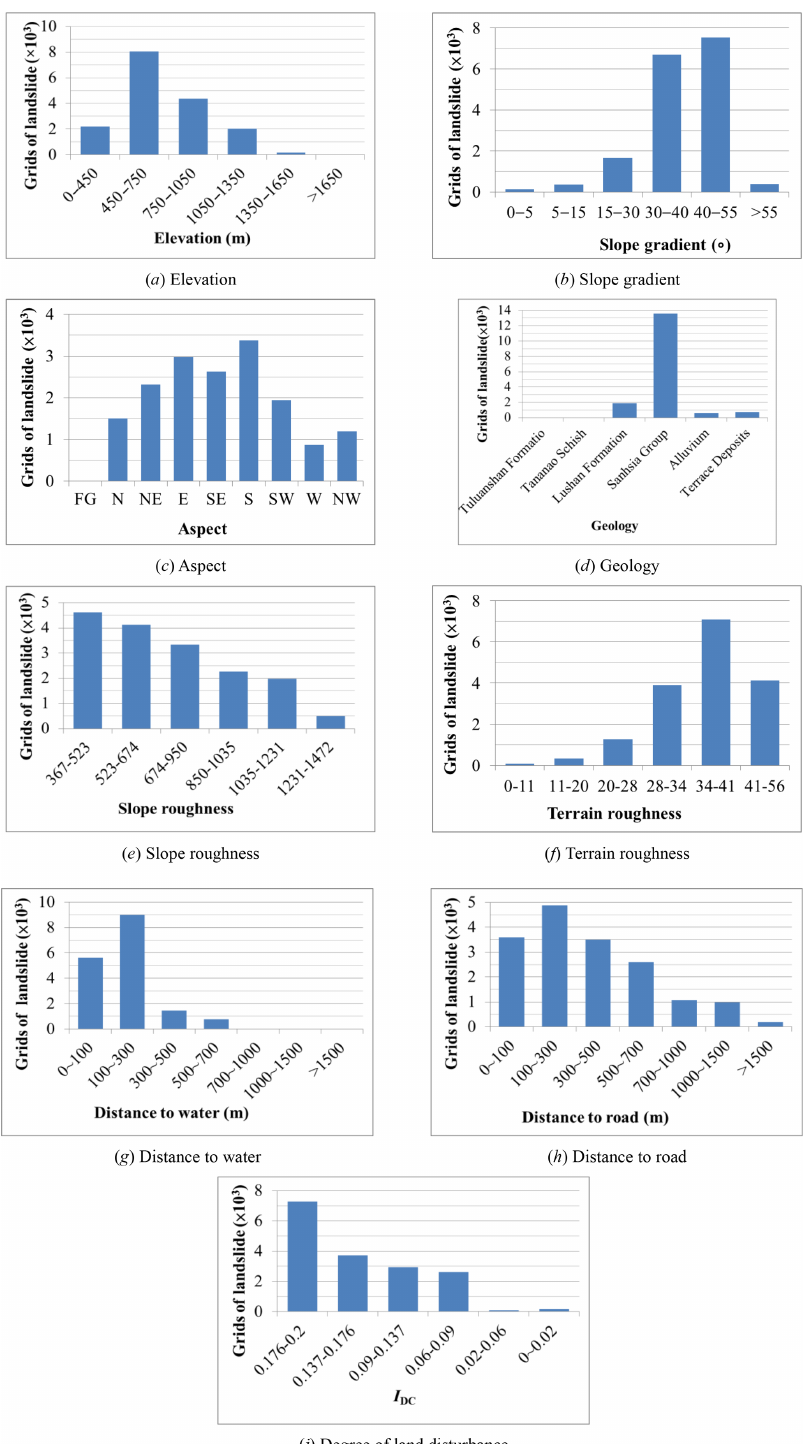
Figure 6. Relationships between landslide predisposing factors and number of landslide pixels in the study